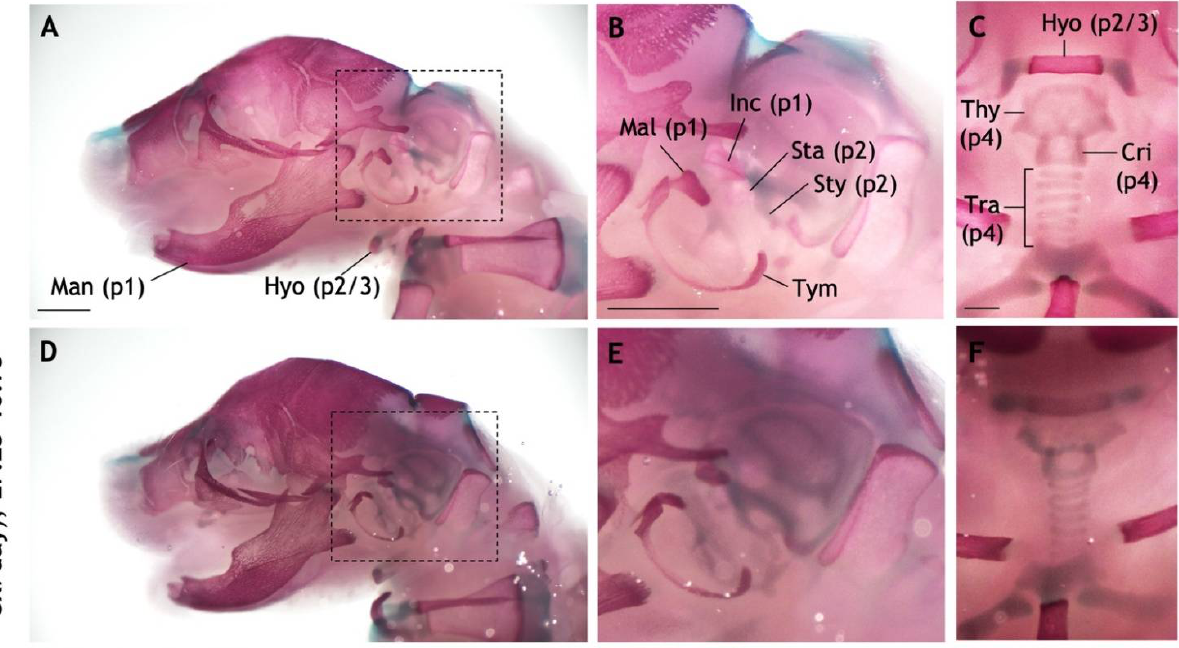
Figure 9. Repeated administration of high APAP dosage to pregnant mice does not recapitulate craniofacial defects. ( A – I ) Pregnant dams were administered via oral gavage three times daily: Sa- line between E10.25–13.75 ( A – C ), 200 mg/kg APAP between E7.25–10.75 ( D – F ), 200 mg/kg APAP between E10.25–13.75 ( G – I ). The resulting pups were collected at P0 and stained with alcian blue (cartilage) and alizarin red (bone). ( A – C ) A control pup with pertinent bones and cartilages labeled. Pharyngeal arch-derived structures are indicated with parentheses (e.g., “p1” = derived from the first pharyngeal arch). ( D – F ) In a pup whose mother was treated with APAP between E7.25–10.75, all labeled structures develop normally. ( G – I ) No defects seen in a pup whose mother was treated with APAP between E10.25–13.75. Dashed boxes in ( A , D , G ) are the fields of view for panels ( B , E , H ), respectively. Abbreviations: cricoid cartilage, Cri; hyoid, Hyo; incus, Inc; malleus, Mal; mandible, Man; stapes, Sta; styoid process of the temporal bone, Sty; thyroid cartilage, Thy; tracheal cartilages, Tra; tympanic, Tym. Scale bars in ( A – C ), 1 mm. 4. Discussion In this study, we demonstrate that high APAP exposure causes craniofacial defects in zebrafish, and importantly, that pharyngeal arch-derived cartilages and muscles are primarily affected. Patterns of apoptosis in the head suggest that APAP may target early pharyngeal arch development. Though many migrating neural crest cells (NCCs) and their cranial chondrocyte derivatives continue to express sox9a/sox10 as expected, some APAP-treated embryos exhibit a breakdown in cartilage differentiation as exemplified by their failure to express col2a1 in the head. This analysis provides a basis for uncovering the molecular mechanisms of APAP interference with craniofacial development.